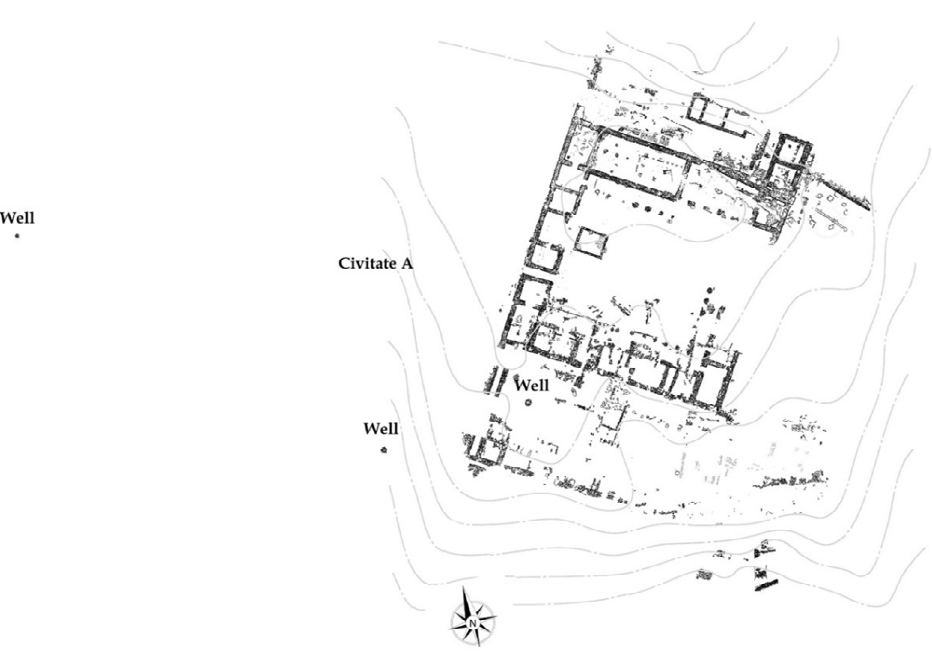
Figure 2. Site plan of the Archaic Complex architectural remains, dating to 600–535 BCE (Image: Poggio Civitate Project).